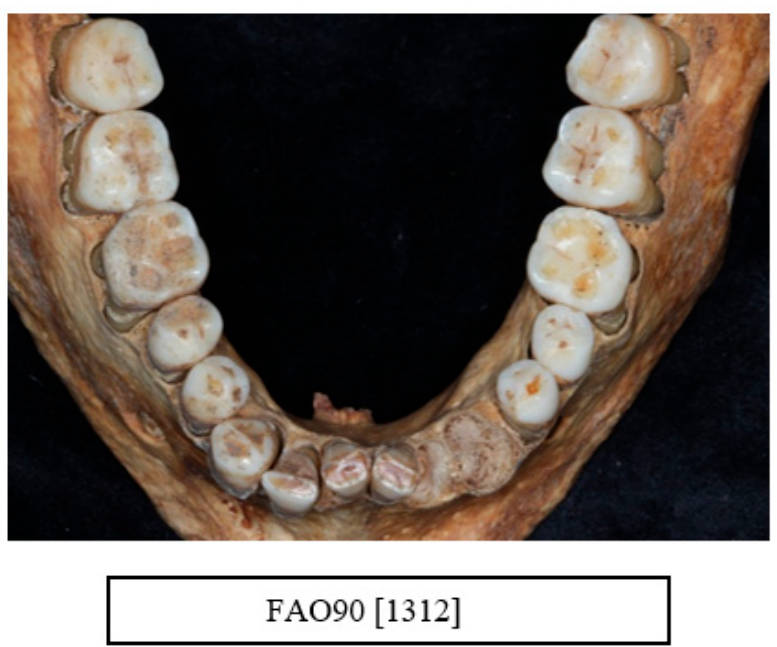
Figure 9. A 36–45-year-old male with generalised occlusal attrition in the mandible (lower jaw). Note the degree of tooth wear associated with the pattern of tooth eruption (courtesy of the Museum of London).